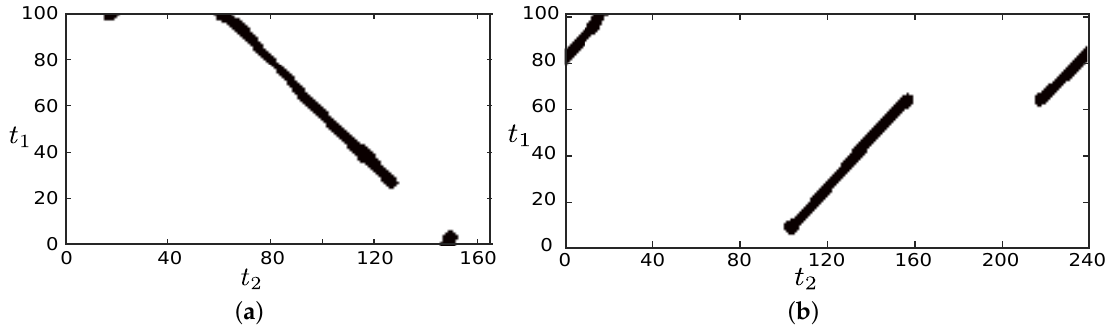
Figure 4. Examples of binarized distance matrix. ( a ) example 2; ( b ) example 3.